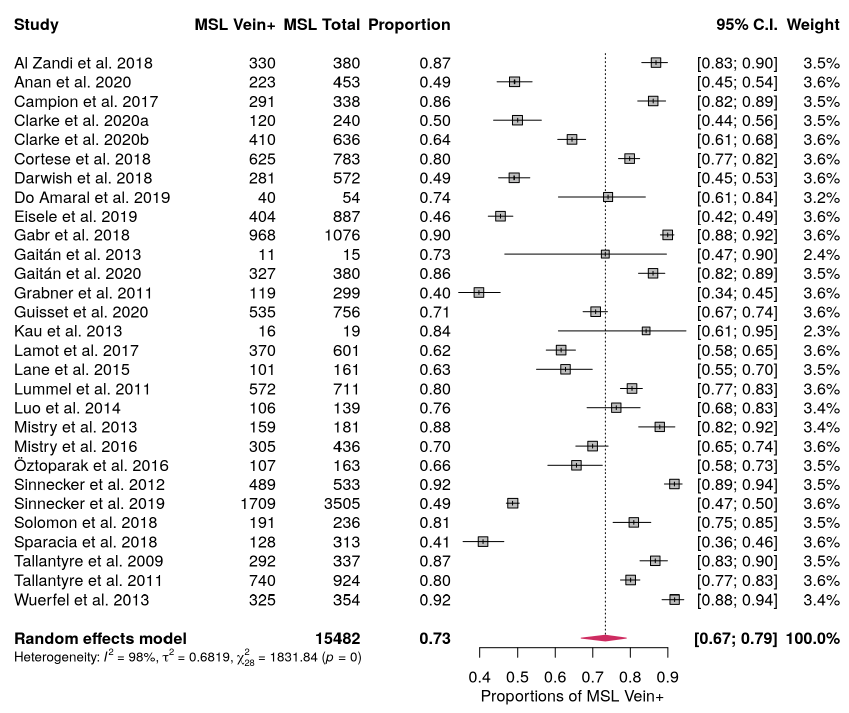
Figure 3. Forest plot showing the proportion of MS lesions with central vein sign (MSL Vein+) and the weight in the Random effect model for each study considered. Proportions are reported with estimated 95% confidence intervals (C.I.). In bold are reported the total number of MS lesions, the pooled proportions and the pooled C.I. and the total weights.